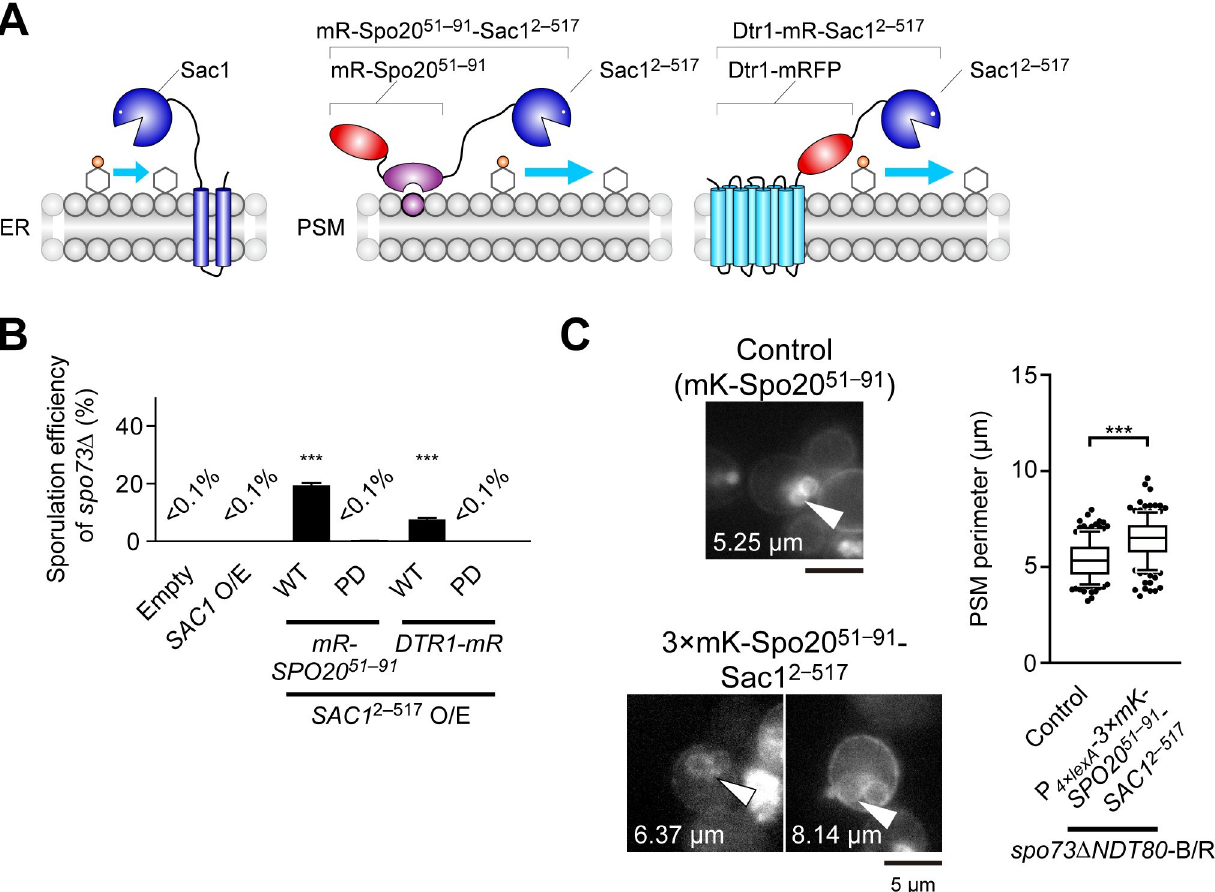
Fig 4. Selective depletion of PI4P in the PSM suppresses the defects of spo73 Δ . (A) Diagram of full length Sac1 and Sac1 2–517 chimera proteins. Sac1 2–517 : catalytic domain of yeast Sac1 (2–517 aa). See text for details. mR, mRFP. (B) Assessment of sporulation in spo73 Δ (TC545) overexpressing constructs encoding full length Sac1, phosphatase active (WT) or phosphatase-dead (PD) Sac1 2–517 chimera proteins. More than 200 cells were observed in three independent colonies of each strain harboring indicated plasmids (for a total of > 600 cells). The bar graph shows the mean of the percentage of asci (N = 3). ��� , p < 0.001 (Tukey-Kramer test). (C) Left: Representative cells are shown. The perimeter of the PSM indicated by white arrow heads are shown. Right: Assessment of perimeter of the PSM in spo73 Δ NDT80 -B/R producingmKate2-Spo20 51–91 (TNY198), as a control, or 3 × mKate2-Spo20 51–91 -Sac1 2–517 from β -estradiol inducible promoter (TNY578). More than 50 PSMs were measured in three independent colonies of each strain (for a total of 151 or 152 PSMs, respectively). The whiskers indicate the 10th and 90th percentiles and dots indicate outliers. ��� , p < 0.001 (Student’s t test). mK, mKate2. Scale bar, 5 μ